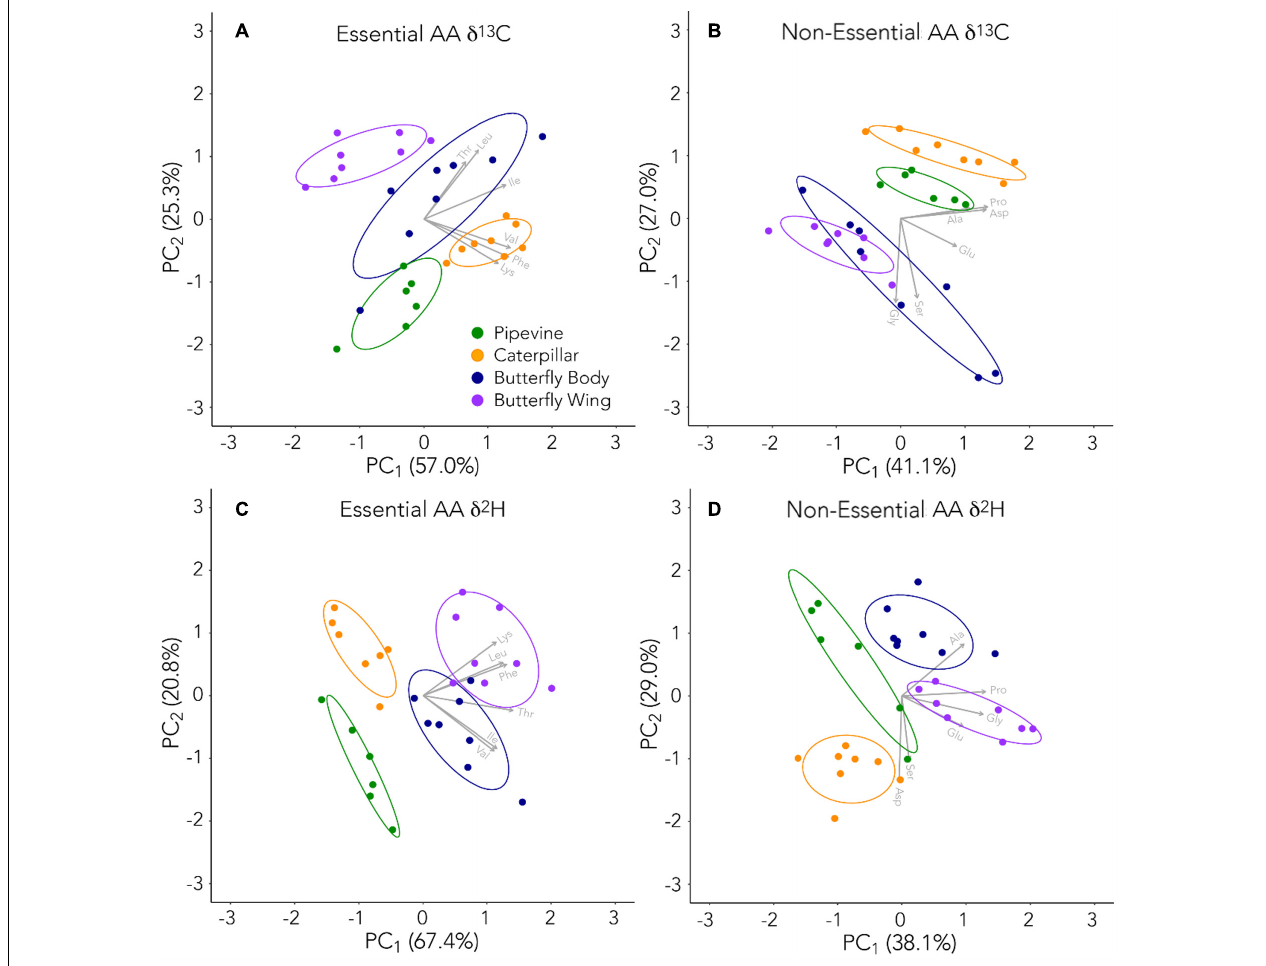
FIGURE 3 | PCA plots of δ 13 C (A,C) and δ 2 H (B,D) data for essential and non-essential amino